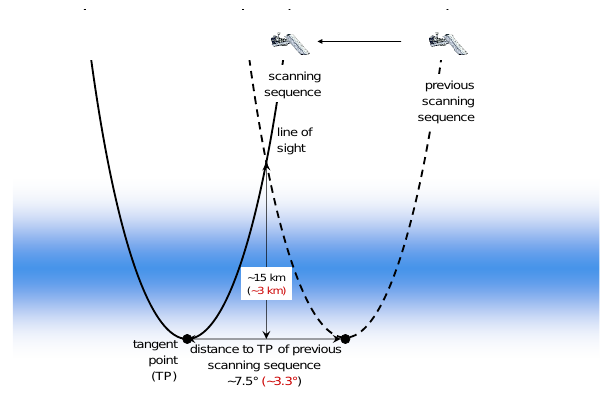
Fig. 1. Spatial overlap of the LOSs of two consecutive scanning sequences (for the same TH). If the distance between their TPs is 7.5 ◦ (nominal SCIAMACHY orbits), they intersect ∼ 15km above the TH indicating rather poor spatial overlap. On the other hand, for a distance of 3.3 ◦ (full limb orbits), they cross ∼ 3km above the TH.